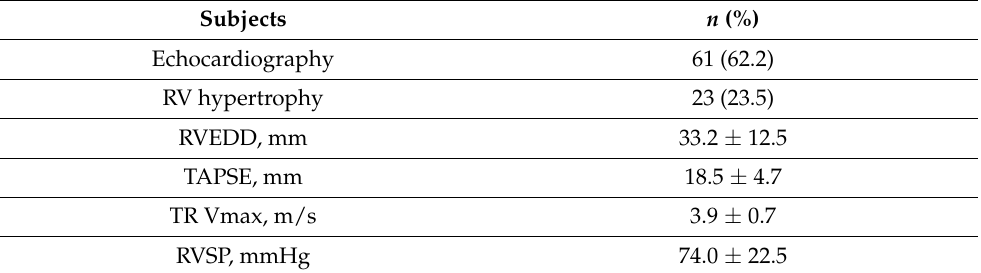
Table 3. Cont. Subjects n (%) Echocardiography